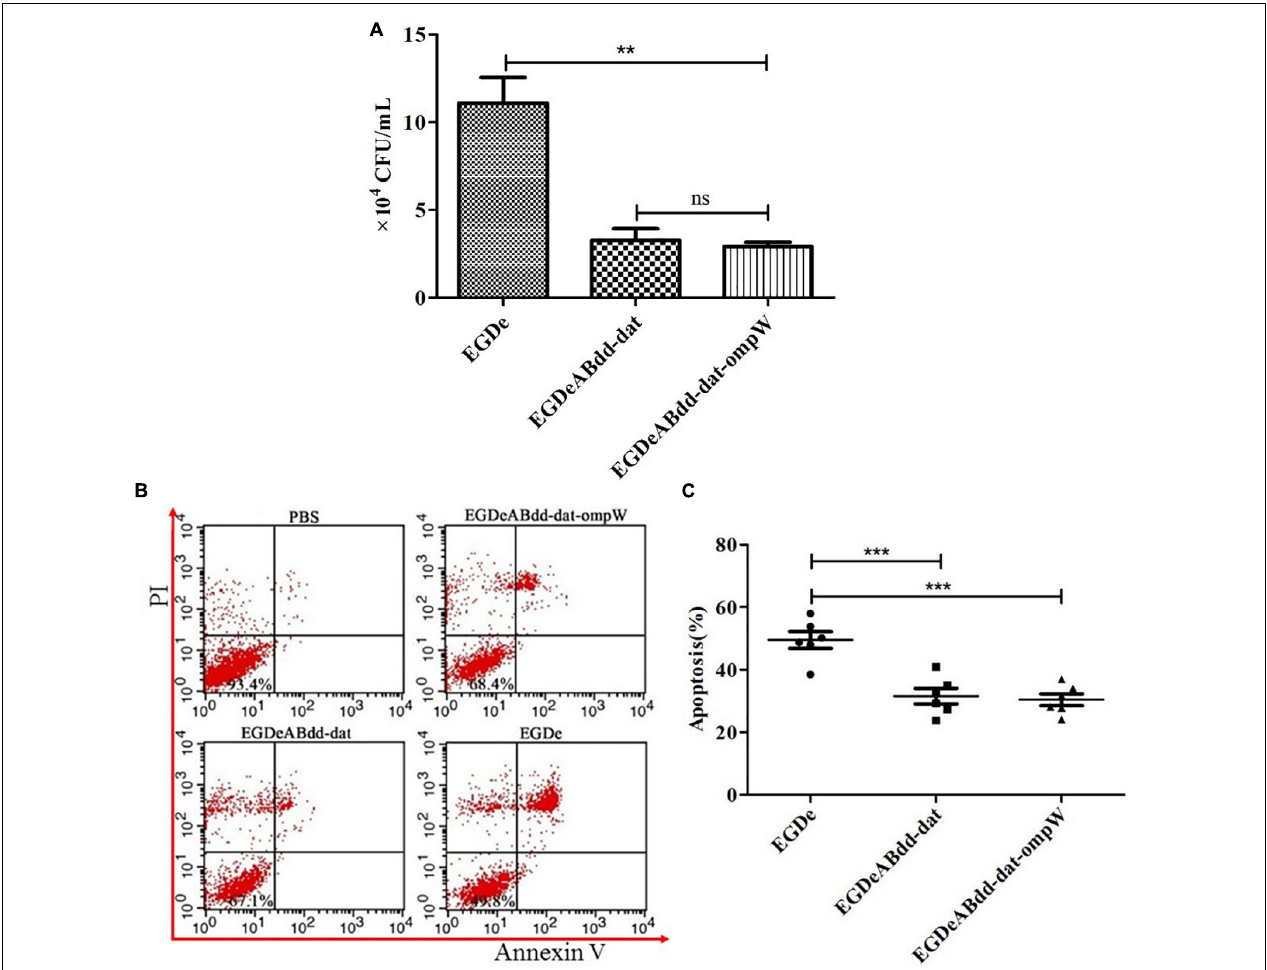
FIGURE 7 | Cytotoxicity of EGDe , EGDeABdd-dat , and EGDeABdd-dat-ompW to Caco-2 cells. (A) Number of bacteria invading into cells. The Caco-2 cells were cultured in 12-well plates at 1.0 × 10 5 cells/well and infected with EGDe , EGDeABdd-dat , and EGDeABdd-dat-ompW at multiplicity of infection (MOI) = 1:100. The infected cells were lysed in 1% Triton X-100 and diluted. The dilutions were counted in brain heart infusion (BHI) plates. (B) Impact of EGDe , EGDeABdd-dat , and EGDeABdd-dat-ompW on apoptosis of Caco-2 cells assessed by flow cytometry. Caco-2 cells were invaded by strains for 3 h. The cells were stained with propidium iodide (PI) and fluorescein isothiocyanate (FITC)-conjugated annexin V for 15 min. (C) The rates of apoptosis of EGDe , EGDeABdd-dat , and EGDeABdd-dat-ompW to Caco-2 cells. EGDeABdd-dat and EGDeABdd-dat-ompW had a lower rate of apoptosis than EGDe . ** P < 0.01; *** P <